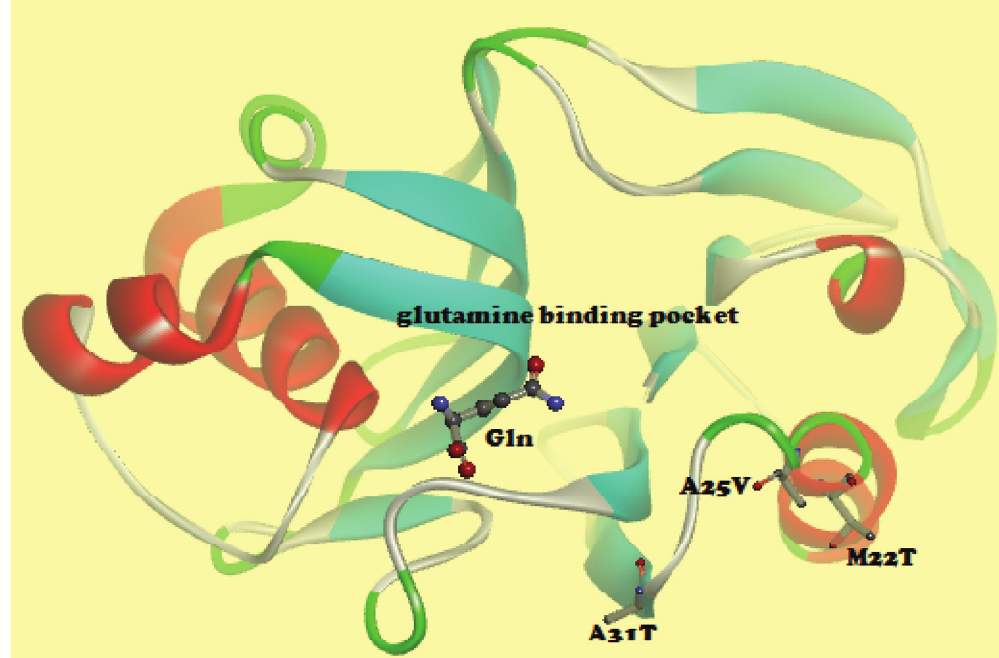
Figure 4 - Homology model of the N-terminal domain of human asparagine synthetase (ASNS) complexed with glutamine (Gln). Amino acid changes due to nonsynonymous mutations in ASNS are indicated.